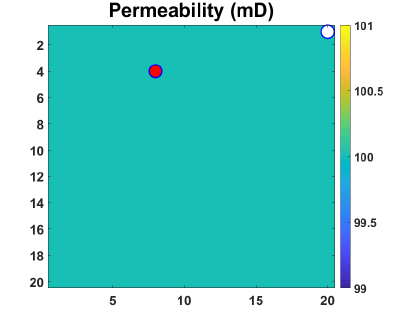
Figure 13. Test case 2 with producer at (8,4) grid block and injector at (20,1) grid block in homoge- neous permeability